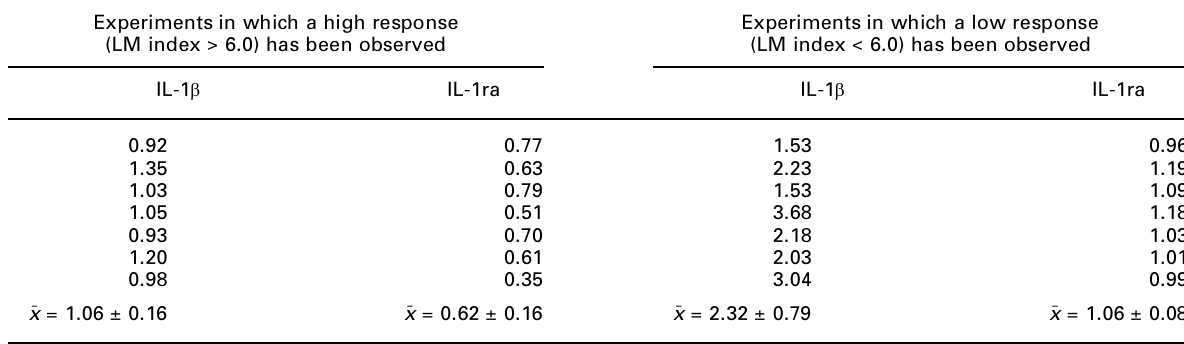
Table 3. Cultures preincubated for 24h and then stimulated with PHA: influence of supplementation with IL-1 b (20ng/ml) or IL- 1ra (20ng/ml) on the values of LM indices Experiments in which a high response (LM index > 6.0) has been observed